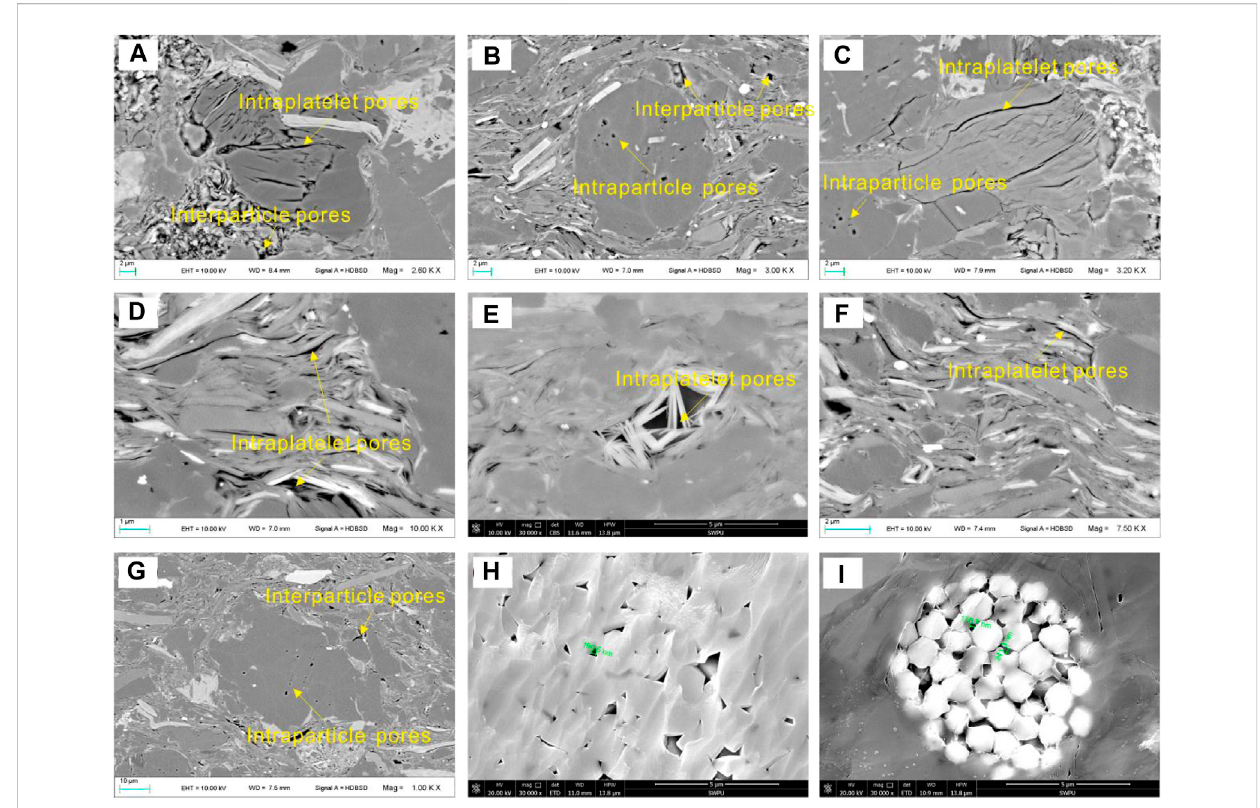
FIGURE 3 High-resolution SEM image of inorganic pores in Lianggaoshan Formation lacustrine shale reservoir. (A) Intraparticle pores in clay mineral aggregates, Type A shale, Well A, 2161.25m; (B) Intraparticle dissolution pores in feldspar granules, Type A shale, Well B, 2455.06m; (C) Type A shale, Well C, 1764.7m; (D) Intraparticleporesinclaymineralaggregates,TypeBshale,WellD,2437.33 m; (E) TypeBshale,WellB,2452.29 m; (F) TypeBshale,WellE,1751.71 m; (G) TypeC shale, Well A, 2164.49 m; (H) Type C shale, Well C, 1928.58 m; (I) Intercrystalline pores in strawberry pyrite aggregates, Type C shale, Well D, 2465.48 m